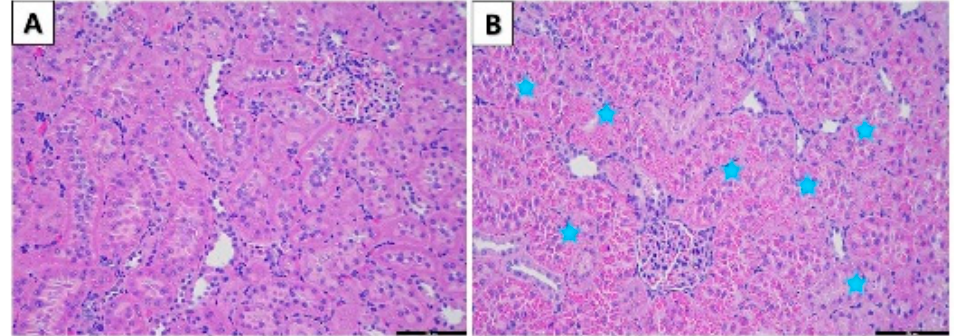
Figure 2. Histopathological changes of male SD rats in the 28-day oral administration toxicity test. ( A ) Normal microscopic structure of the kidney of a male SD rat (×200 magnification). ( B ) Hyaline droplet in the kidney of a male SD rat administered 100 mg/kg chlorobutanol (×200 magnification). Scale bar: 200 μ m.